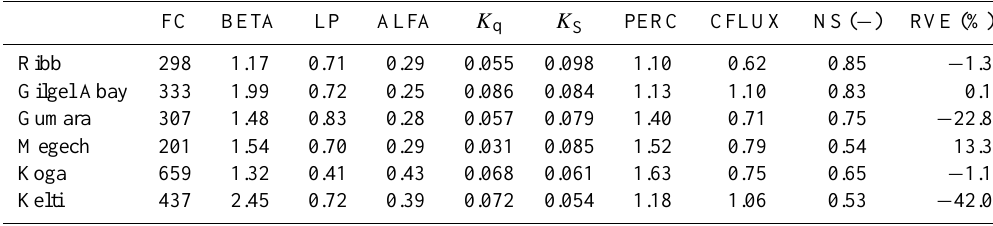
Table 6. Assessment of the regional model for gauged catchments (2001–2003).